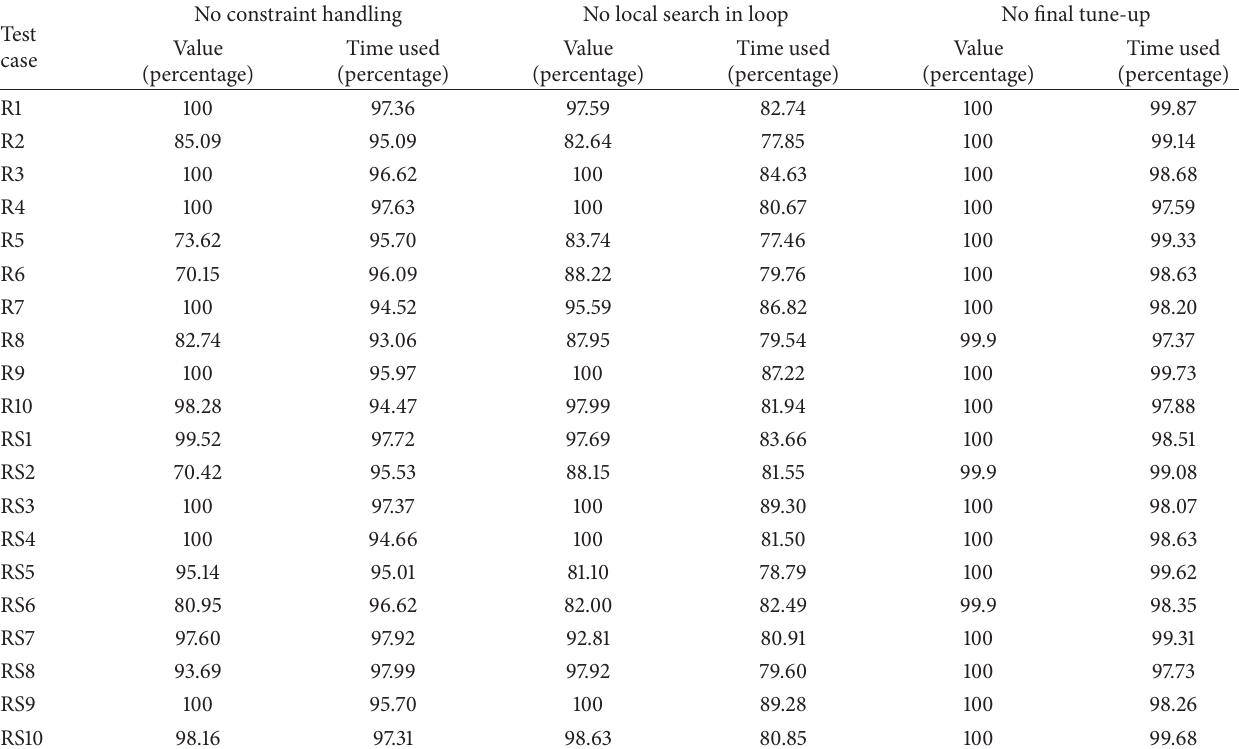
Table 8: Result of performance evaluation